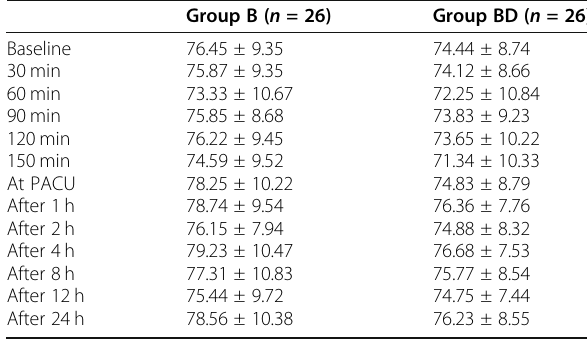
Anterior chest wall in the mid-clavicular line